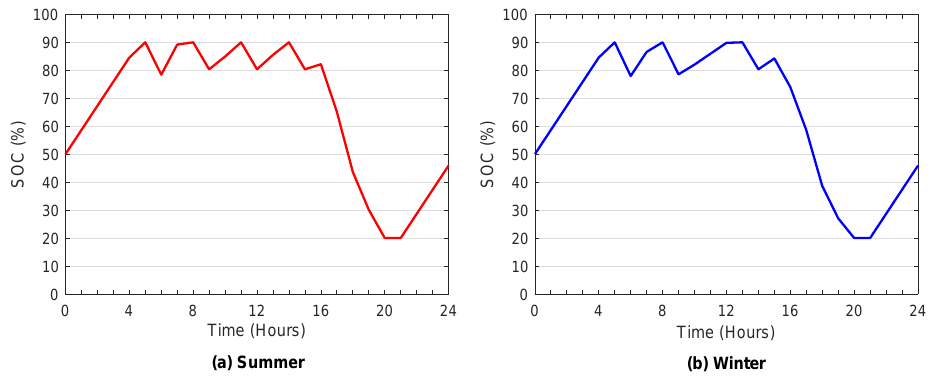
Figure 11. Energy storage system state of charge.